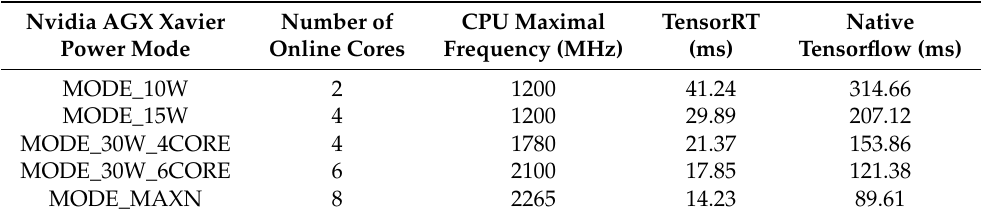
Table 2. Inference time measured on the NVIDIA AGX Xavier with different power mode (nvpmodel) and optimization level